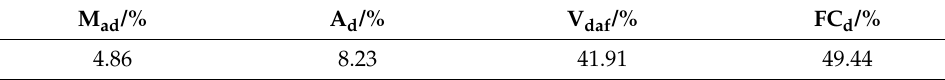
Table 1. Proximate analysis results of the coal sample.